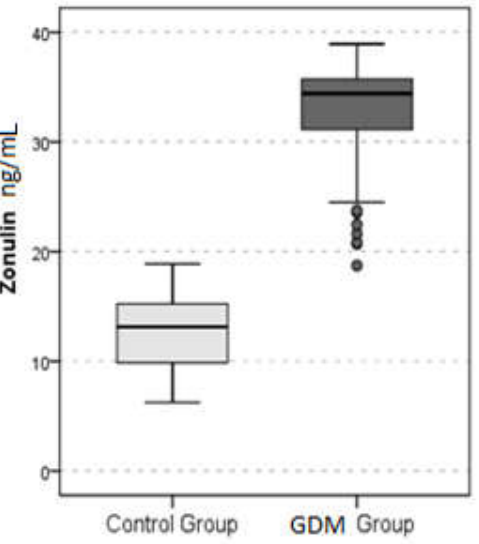
Figure 1. Plasma zonulin levels of the gestational diabetes mellitus (GDM) and control groups.